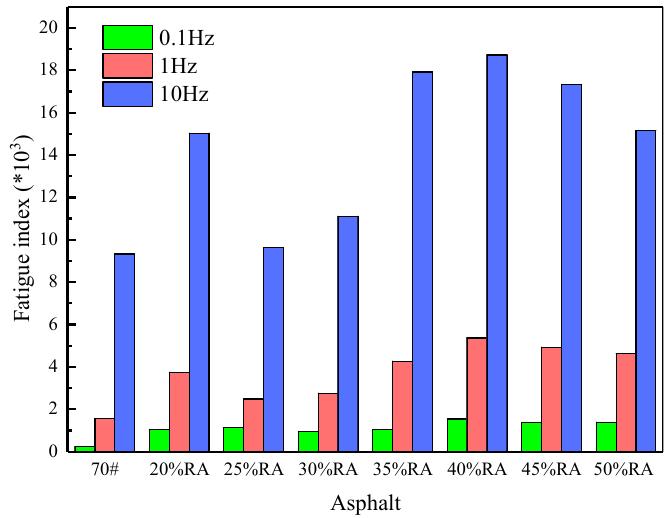
Figure 9. Fatigue index of high-content rubberized asphalt.